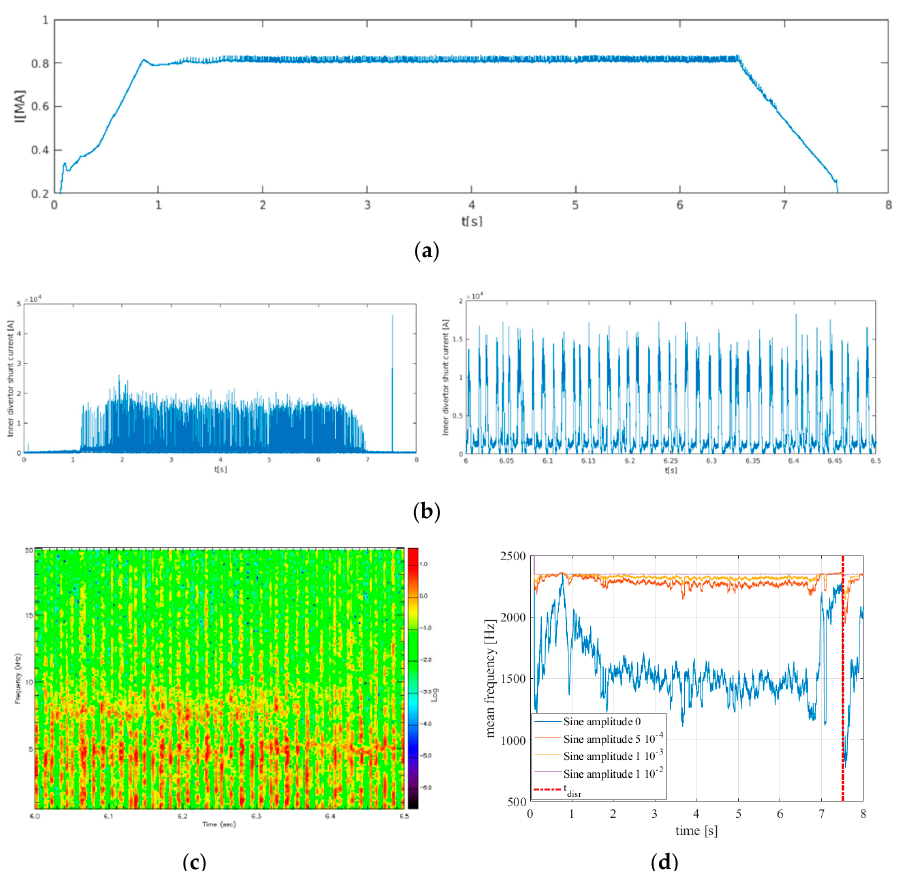
Figure 5. ( a ) Plasma current for the pulse 30735; ( b , left). Inner divertor shunt current where ELMs can be clearly seen up to the disruption at 7.506 s ( b , right) zoom , between 6 s and 6.5 s, of the illustrative ELMy phase; ( c ) Mirnov coil spectrogram showing the ELMy phase. ( d ) The averaged frequency estimator obtained with three different amplitudes for the sinusoidal added term. The highest the amplitude, the less sensitive to oscillations the indicator is. A trade-o ff between robustness and reliability can be achieved using an amplitude of 1